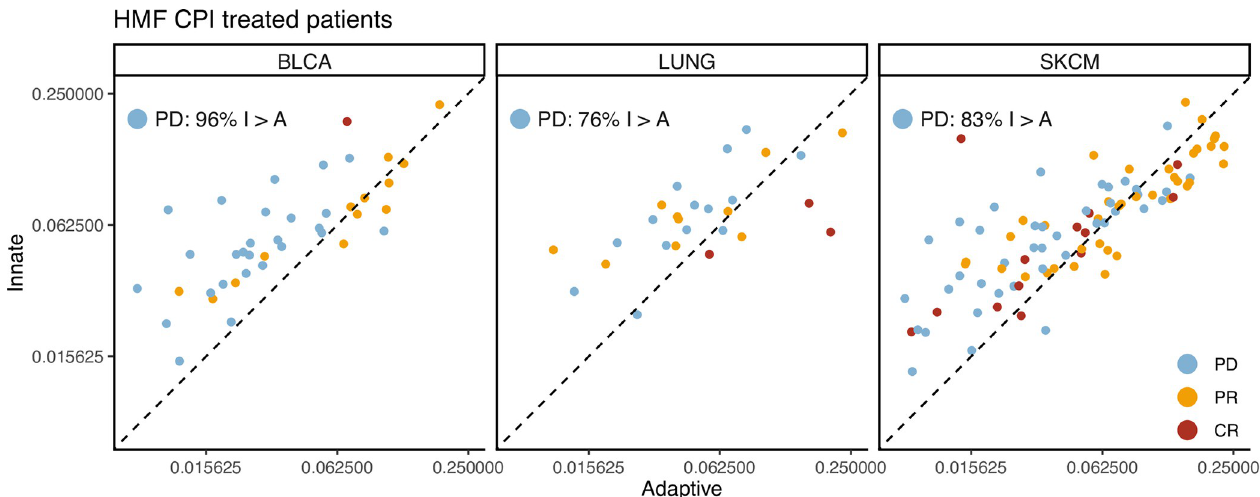
Fig 5. Adaptive vs Innate expression in CPI treated patients. Scatterplots showing the adaptive immune expression vs. the innate immune expression in each patient for the CPI treated HMF cohort. The points are coloured by their response to immunotherapy and the plot is stratified by cancer types.